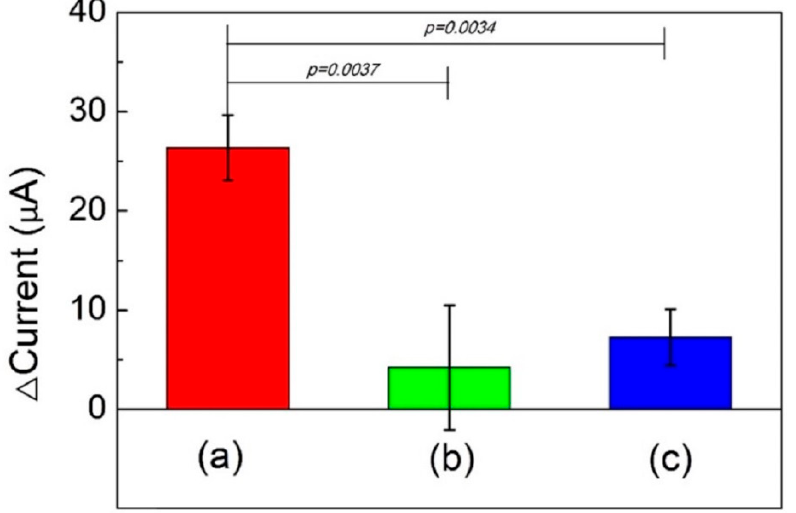
Figure 8. Difference in current between Au/ZnPP and Au/ZnPP/Avastin electrodes ( a ) w/LT reaction for 10 min, ( b ) w/o LT reaction for 10 min, and ( c ) w/o LT reaction for 1.5 h.